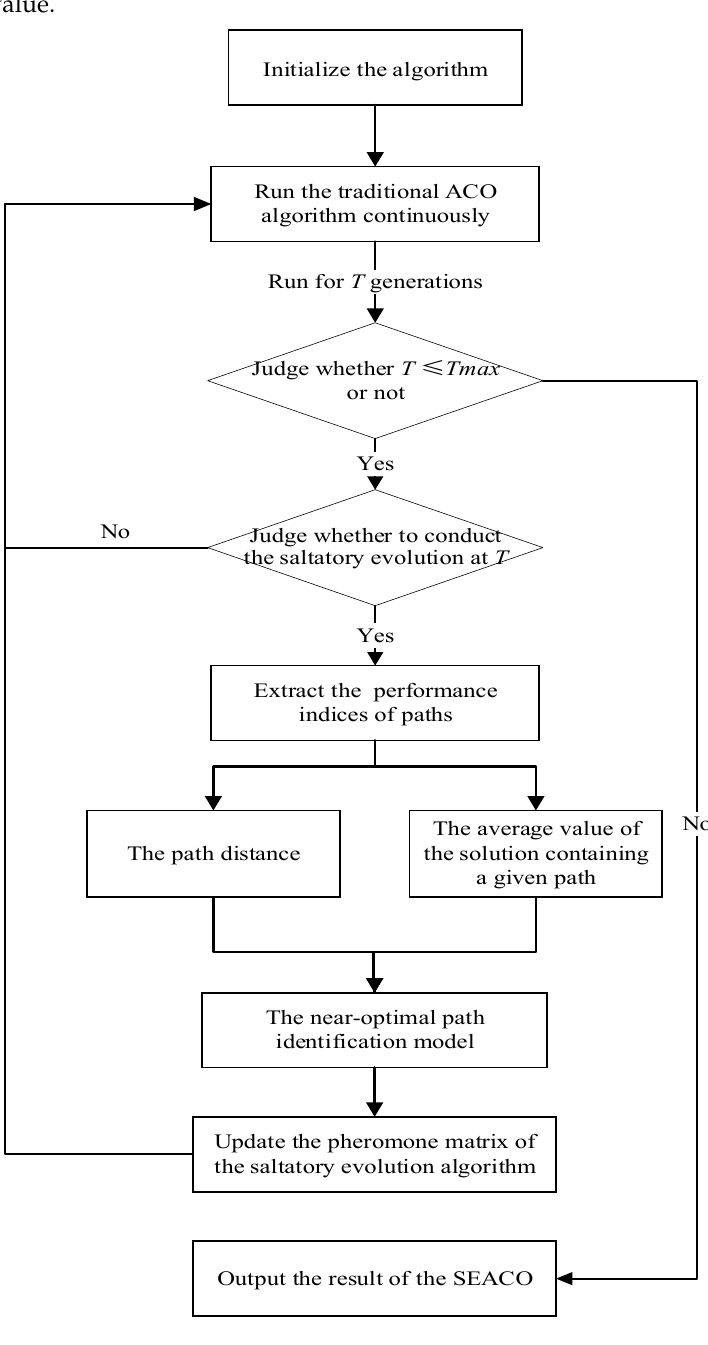
Figure 1. The SEACO algorithm flow chart.